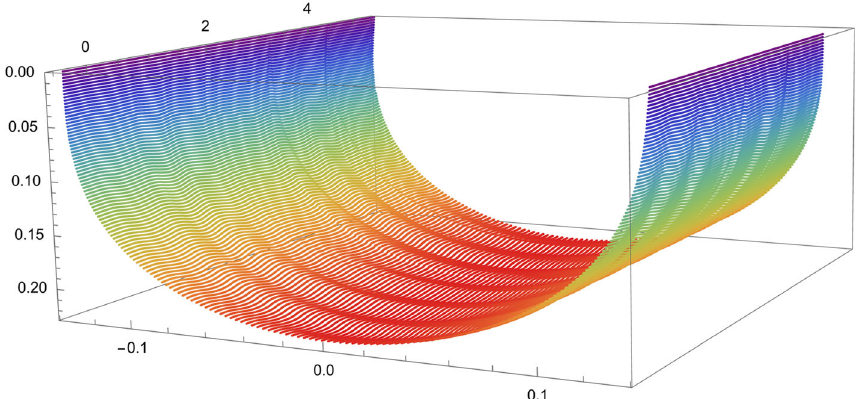
Fig. 10 TimeevolutionoftheclassicalopenstringintheEM-dilaton-Vaidyabackground. Wehavefixedtheinterquarkdistance l = 0 . 27,transition time k = 0 . 3 and the temperature T = 0 . 37 ( lT = 0 . 10 ) . Here, we have μ